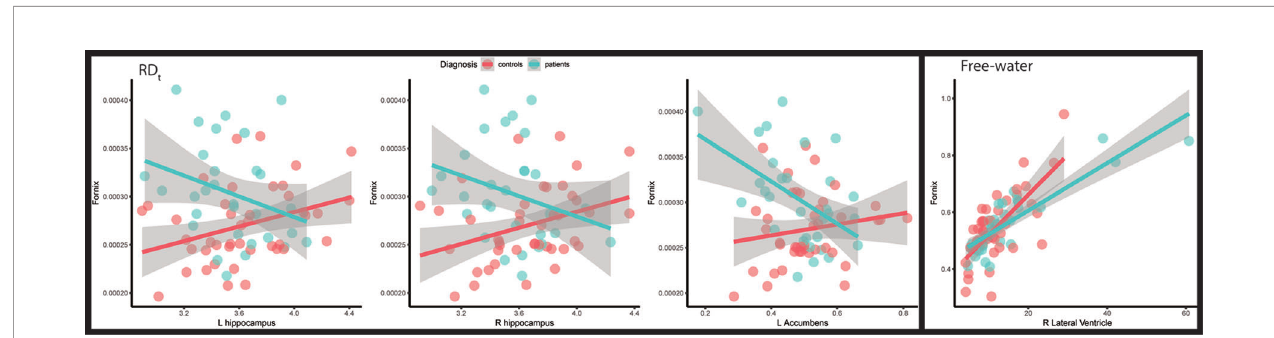
FIGURE 4 | Scatterplots of the fornix with the subcortical structures that have signi fi cant interaction with diagnosis. Fitted lines were created using a generalized additive model. L, Left; RD t , Free-water adjusted Radial diffusivity; R,